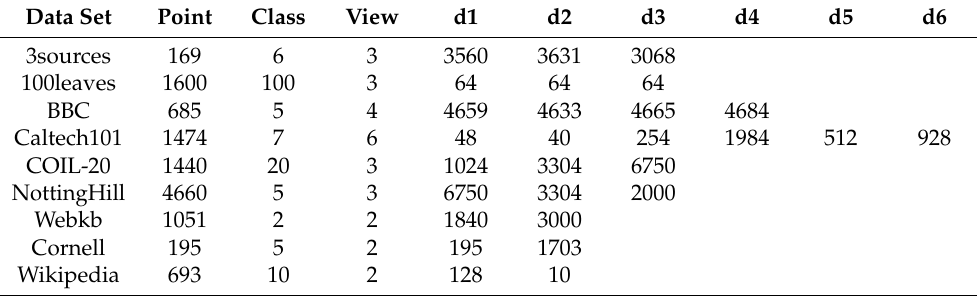
Table 2. Summary of nine multi-view benchmark data sets ( d v denotes the dimensionality of the v -th view). Data